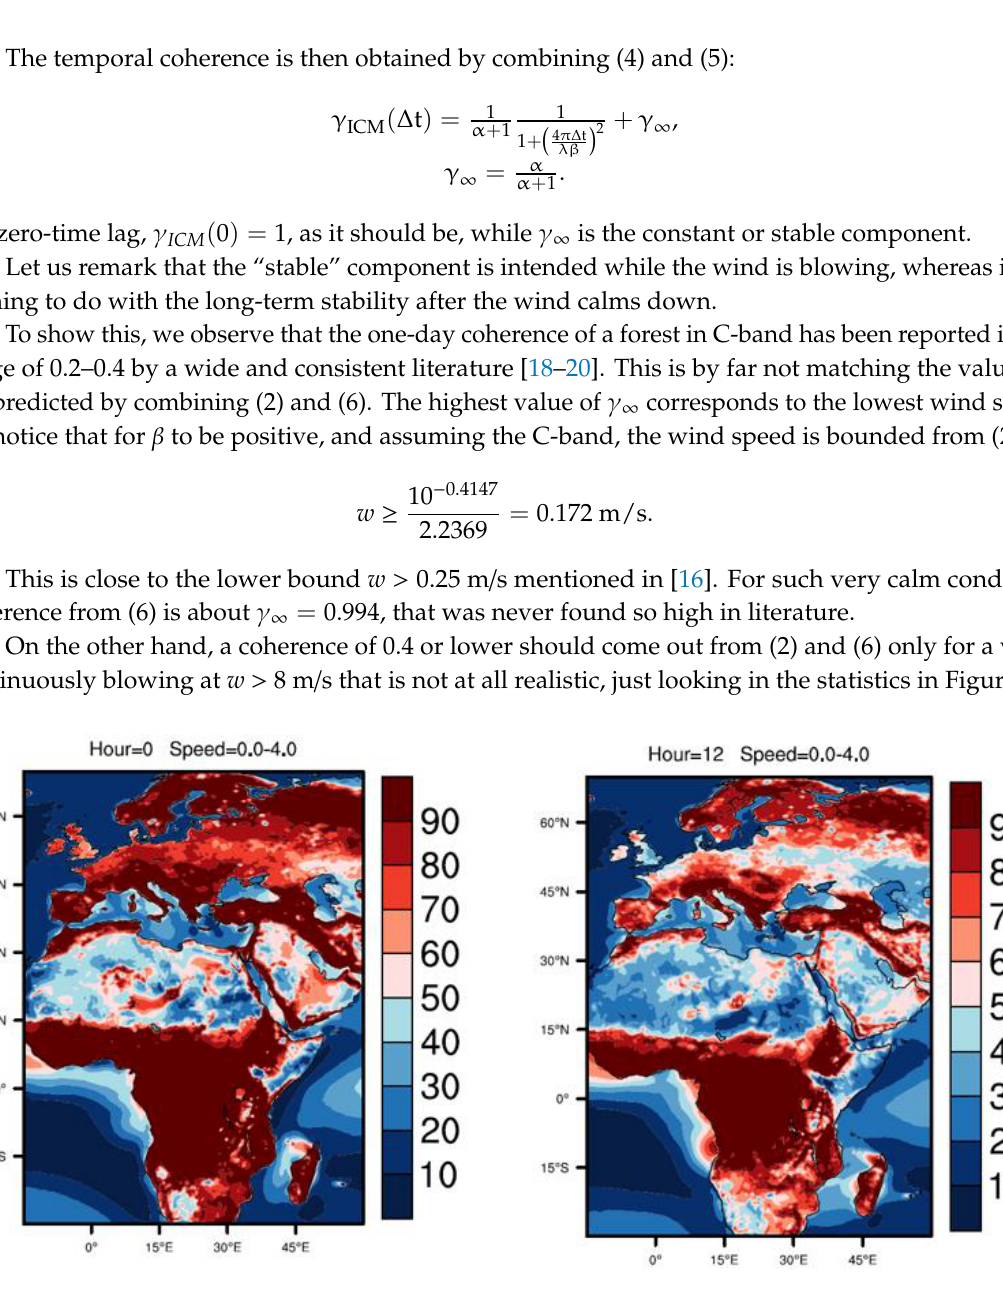
Figure 1. Intrinsic Clutter Model (ICM) model, top left, and measures of Doppler Power Spectrum Density (PSD) by Ku band Ground-Based Radar (GBR) in a rural scene (bottom left), of a fast decorrelating target, top right, and a stable target, (bottom right).